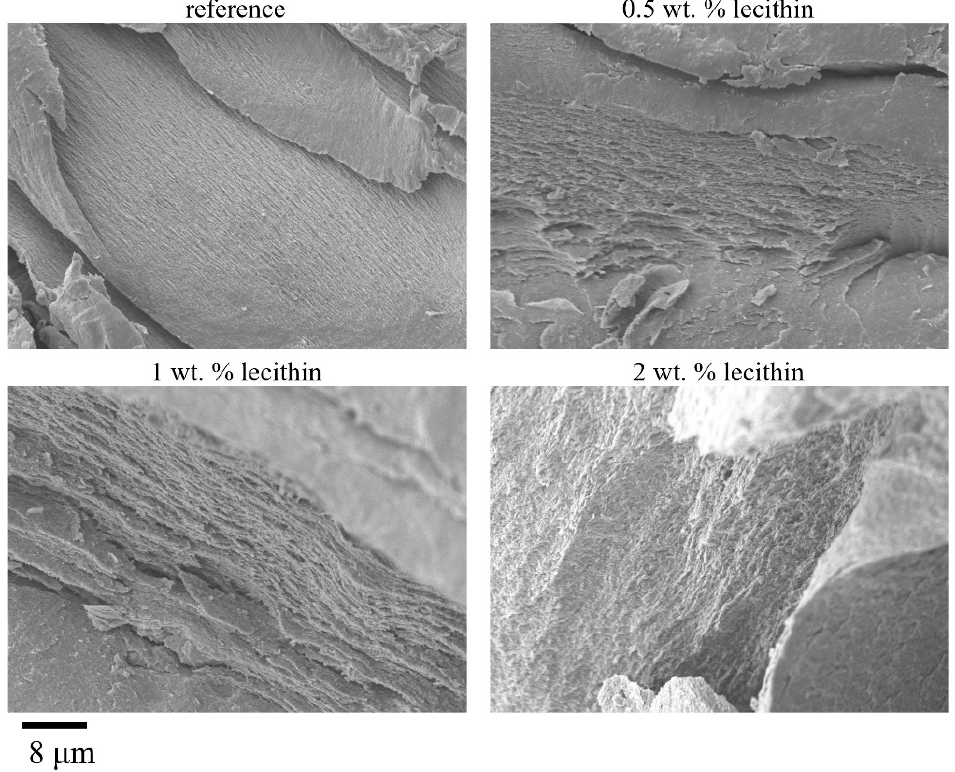
Figure 3. Physically crosslinked agarose xerogels with different lecithin contents observed in sectional view by SEM. Magnification 5000 × .